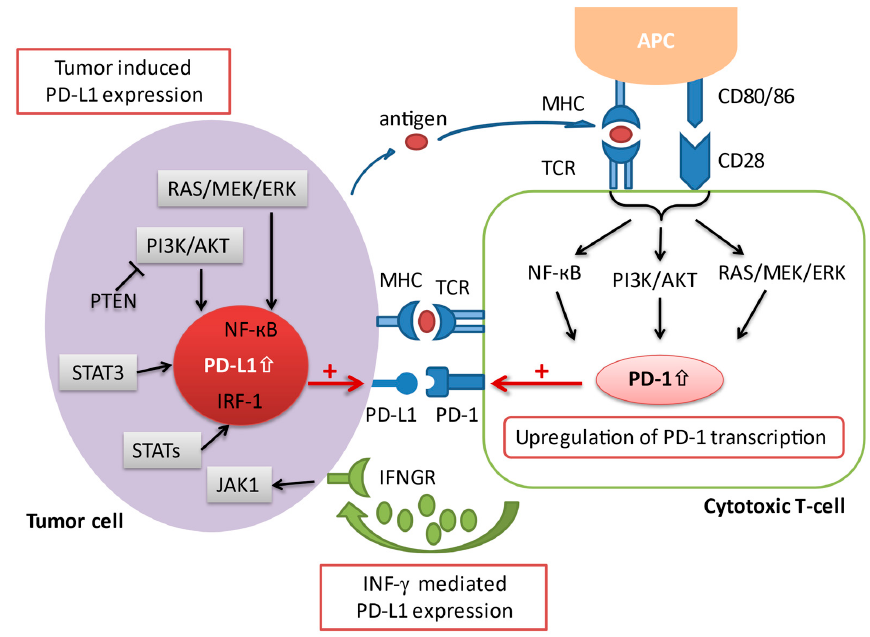
Figure 2. A schematic overview illustrating the various aspects involved in the regulation of PD-